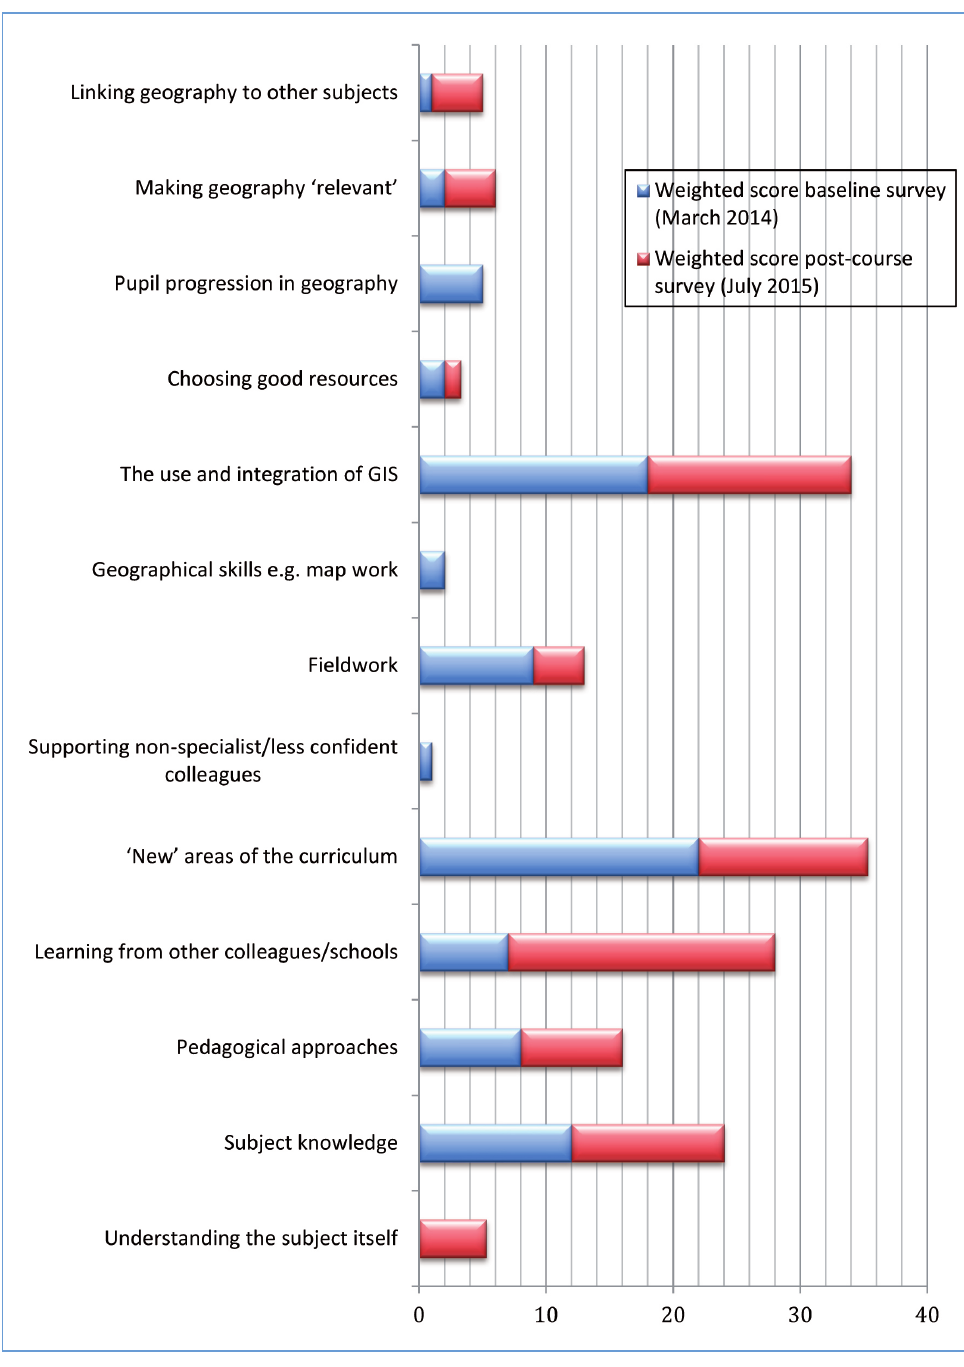
Figure 5: Supportforaspectsofgeographyteaching(secondary).